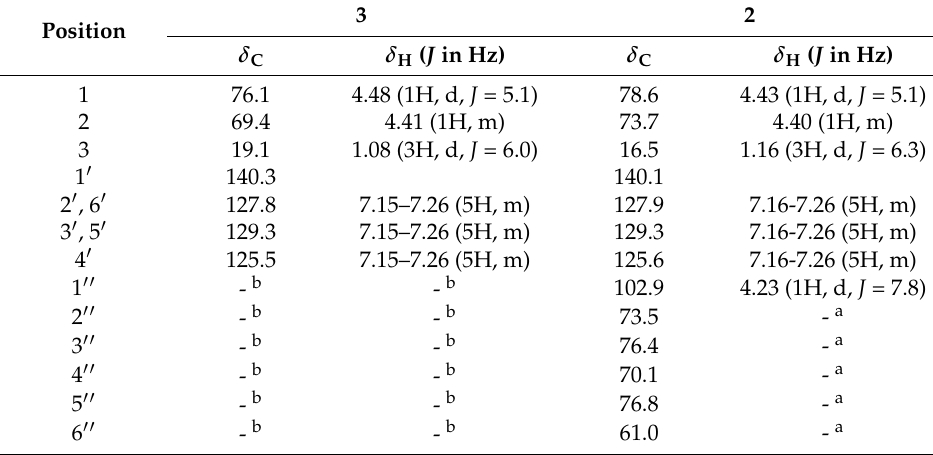
Table 2. 13 C- and 1 H-NMR data for compounds 2 and 3 in DMSO- d 6 ( δ in